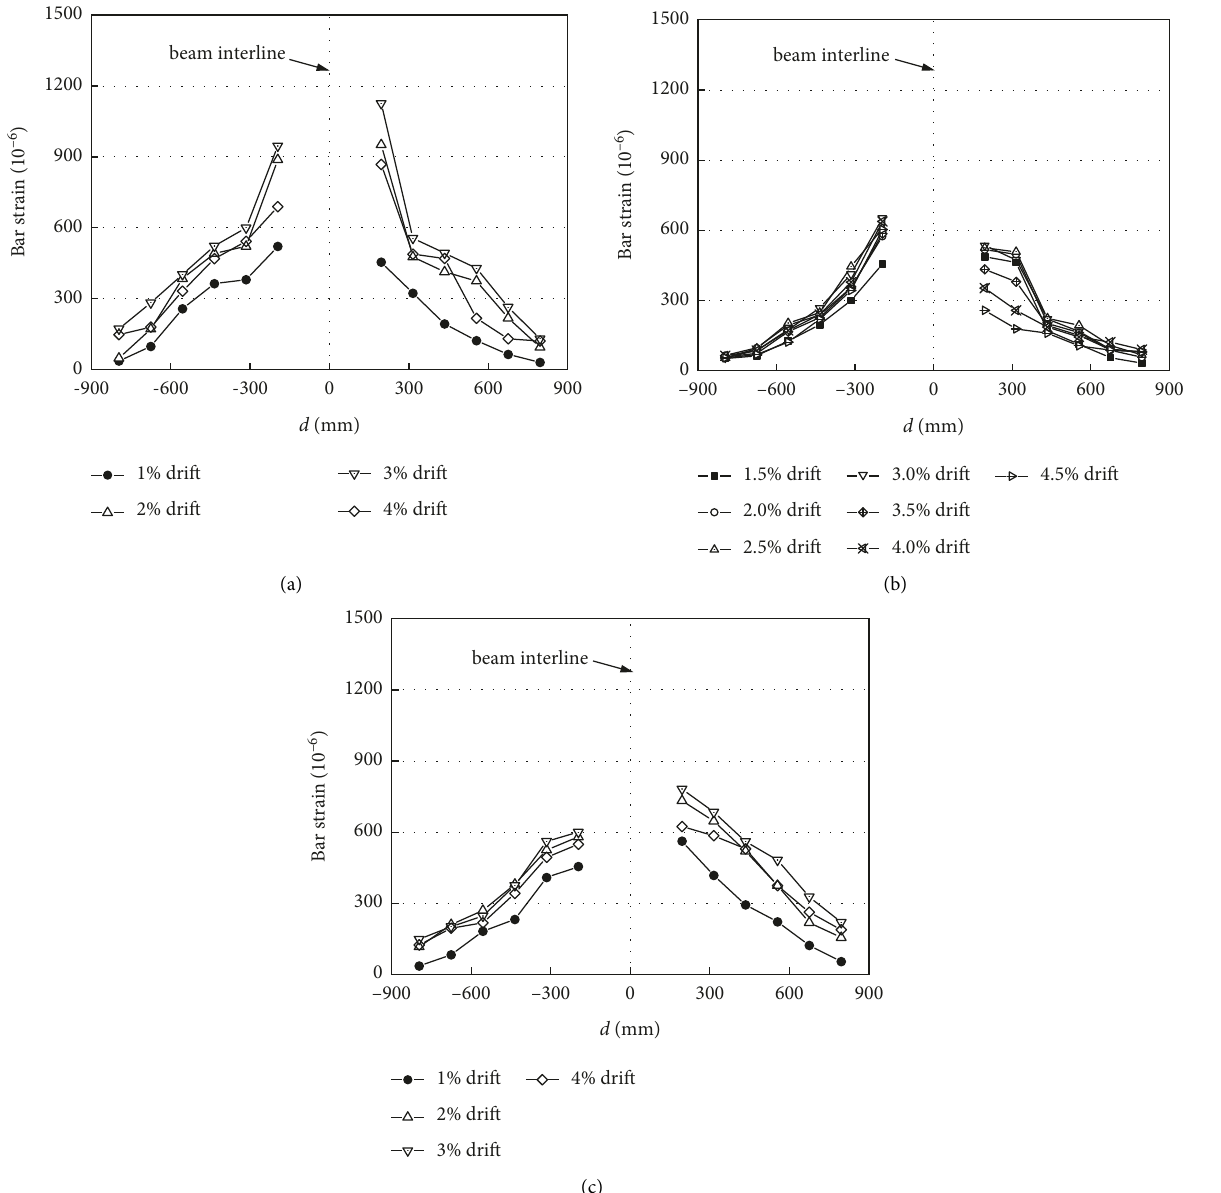
Figure 7: Strain variation of slab top reinforcement. (a) EBCSJ1. (b) EBCSJ2. (c) EBCSJ3.